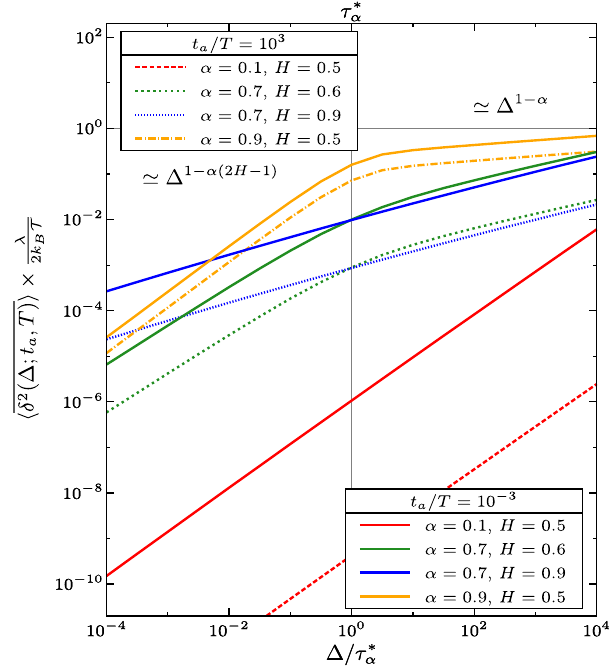
FIG. 7 (color online). Expectation value of the time-averaged squared displacement δ 2 as a function of lag time Δ . Plots graphically represent Eq. (56), for the same system parameters α and H as in Fig. 6. In all cases the duration of the measurement is T ¼ 10 6 . In contrast to the analog ensemble average, the behavior is given by a single turnover at the internal relaxation time scale τ (cid:2) α , no matter at which time t a the recording of the trajectory is =T ¼ 10 3 , dashed or initiated. Results obtained at late age ( t a =T ¼ 10 − 3 , dotted lines) differ from those at early age ( t a continuous lines of same color) merely by a prefactor (displayed as a constant shift in the double logarithmic